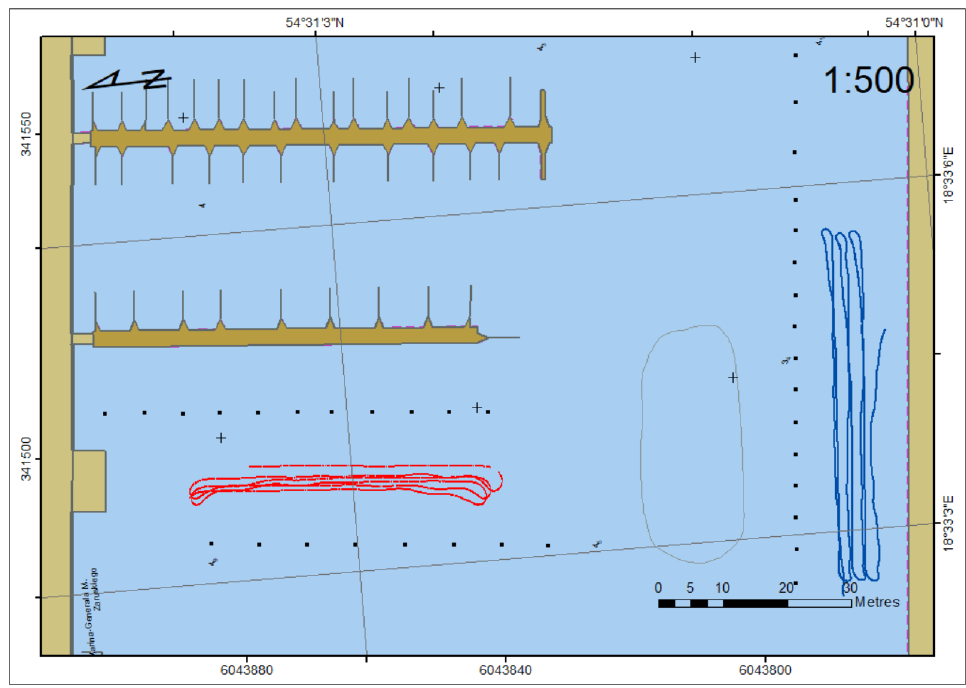
Figure 6. Trajectory of USV during measurements on long, linear profiles.